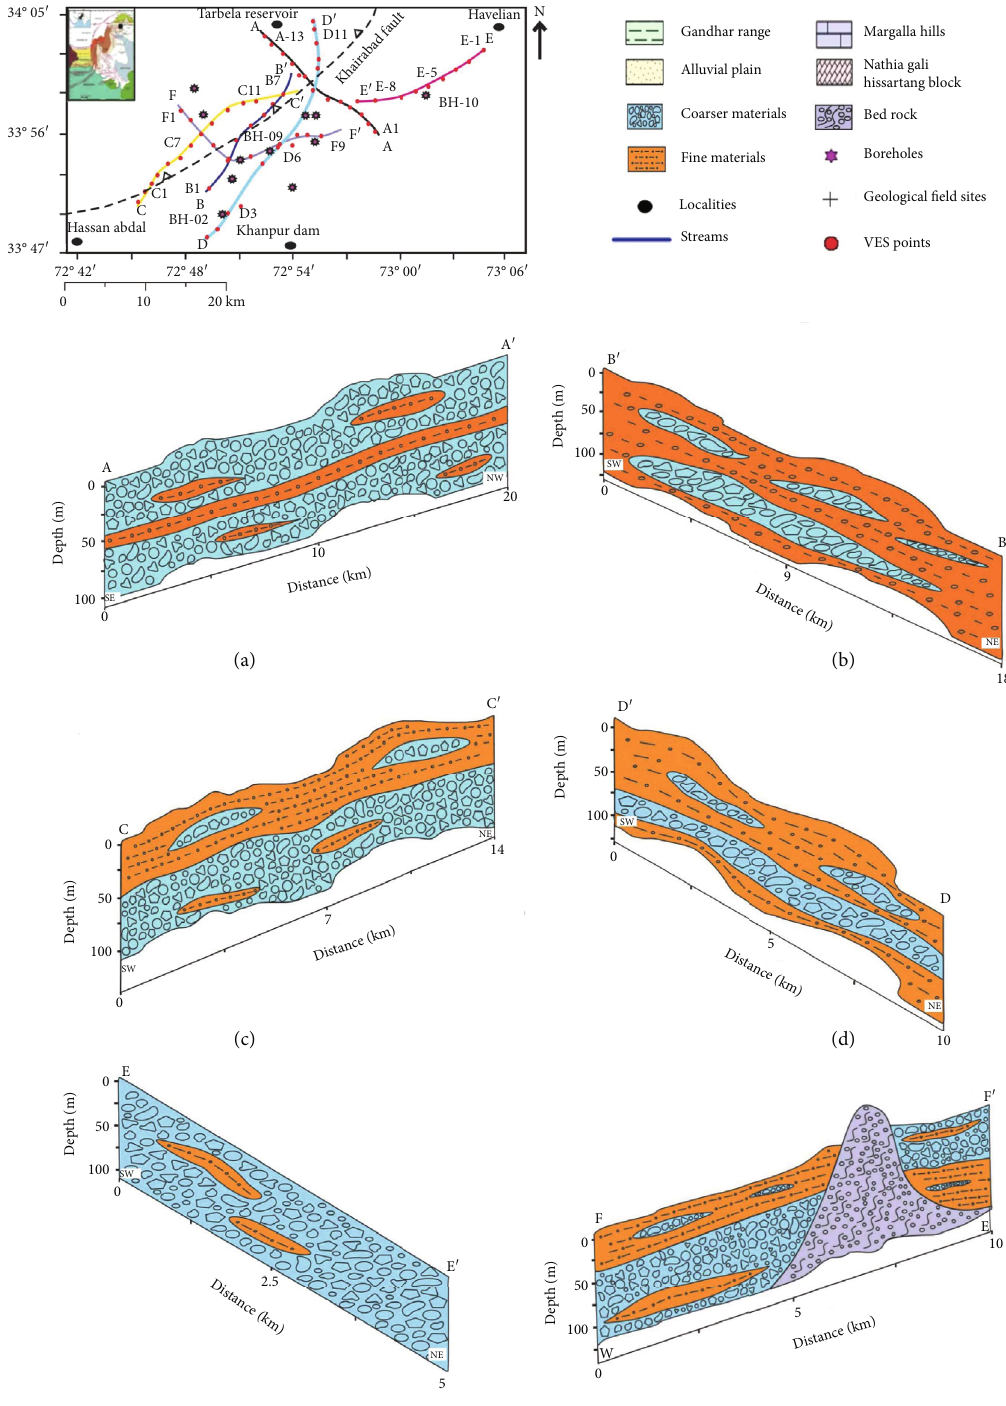
Figure 7: (a – f) Cross-sections based on well-calibrated electrical resistivity values with borehole dataset. Lithological variations across the cross-sections are associated with stream fl uctuations. The orientation of the cross-sections is also represented on this map and also in Figure